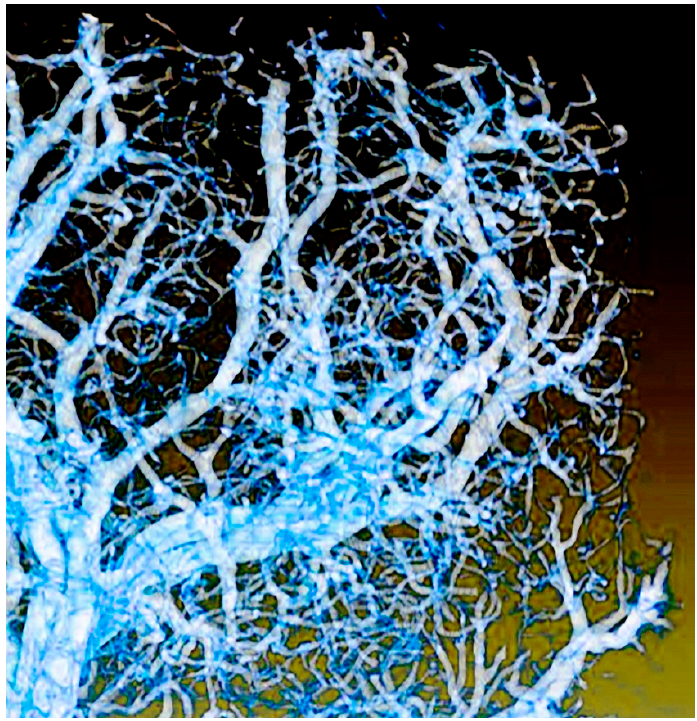
Figure 25. Another example of coherence-based tomography: microvasculature developed in the early stages of tumor growth [38]. Image size 600µm.